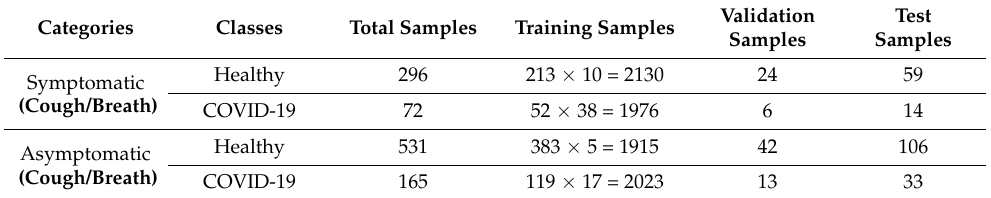
Table 3. Number of mages per class and per fold used for different pipelines.